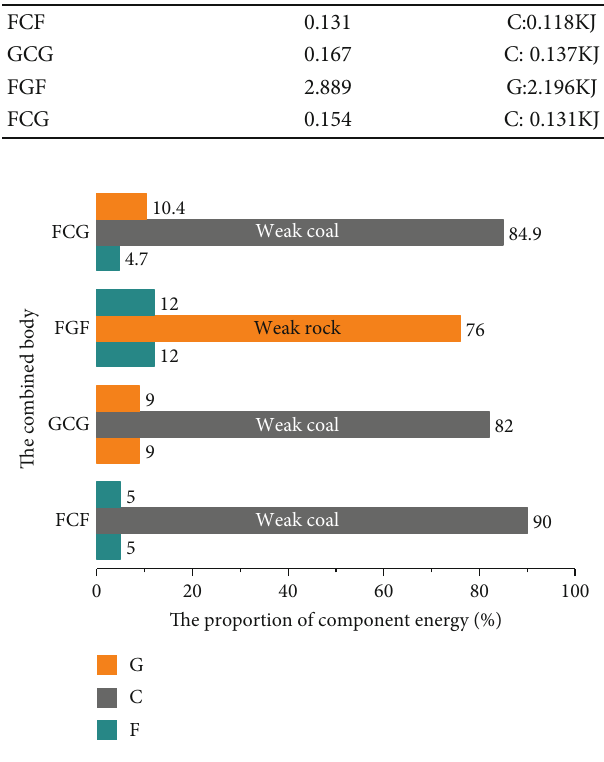
Figure 13: Energy distribution histogram of combined test